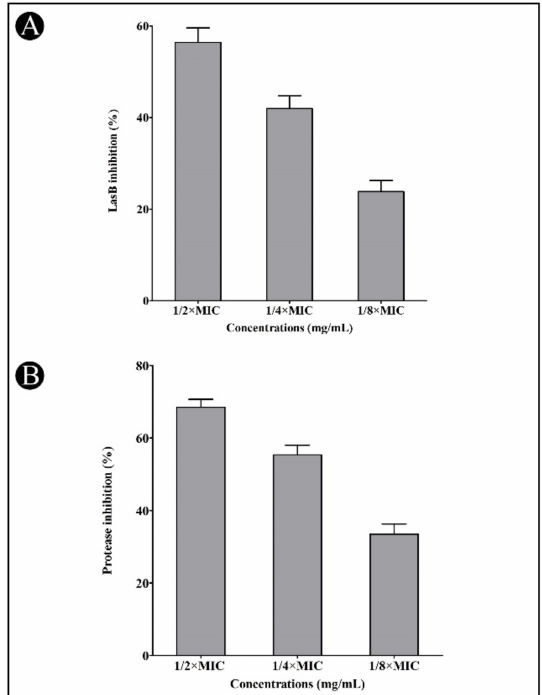
Figure 7. Inhibition of LasB ( A ) and protease ( B ) by synthesized AgNPs in P. aeruginosa at the sub-MIC concentrations (1/2, 1/4 and 1/8 MIC). Values are presented as mean ± SD of three independent tests.